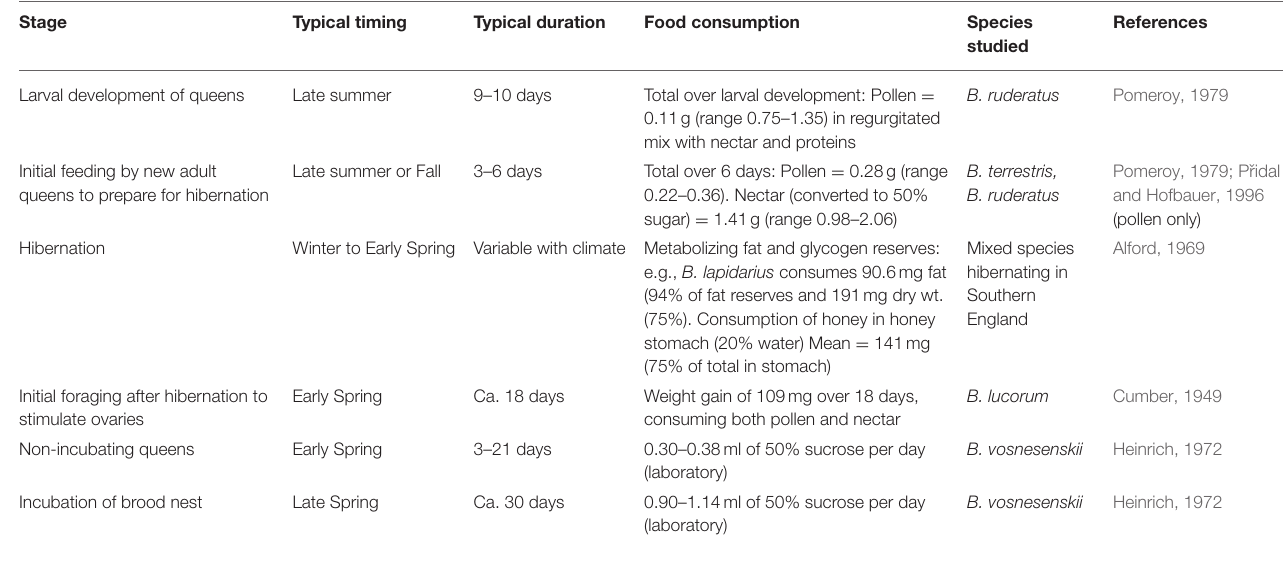
TABLE 1 | Critical periods for nutrition of bumble bee